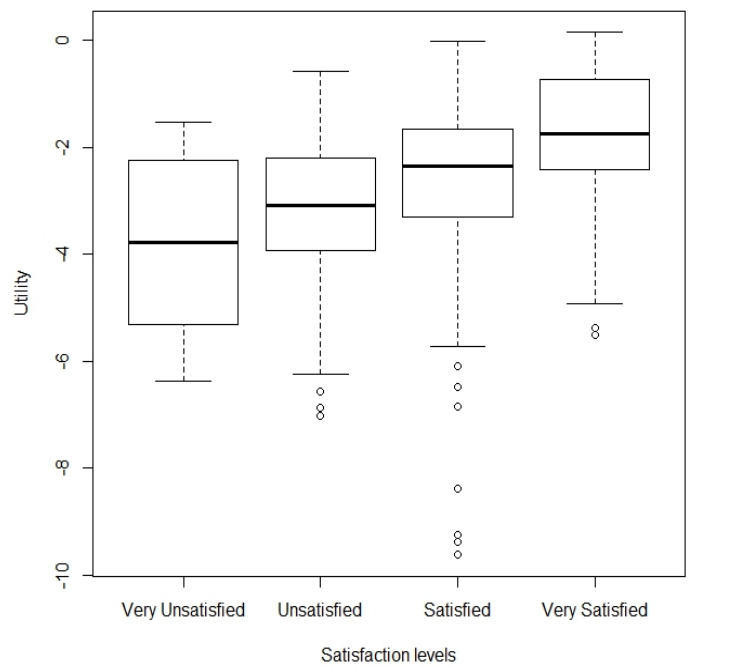
Figure 2. Satisfaction levels and utility of the selected mode In order to analyse the strength of the association between the utility-based Logsum and the stated satisfaction, the multiple regression (Edwards, 1985) and the one-way ANOVA (Christensen, 2011) approaches have been employed. The multiple linear regression is used to explain the relationship between one continuous dependent variable and two or more independent variables. ANOVA is instead a statistical method typically employed to perform analysis of variance between and within